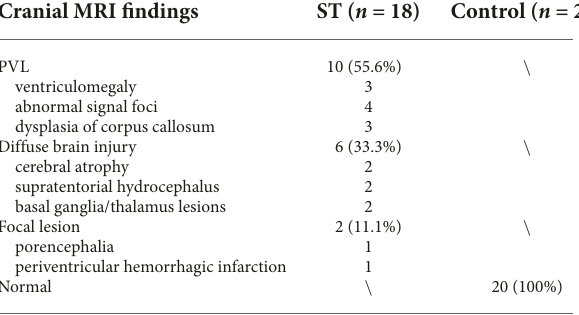
TABLE 3 The appearance of brain MRI in children with spastic CP. Cranial MRI findings ST ( n = 18) Control ( n = 20) PVL 10